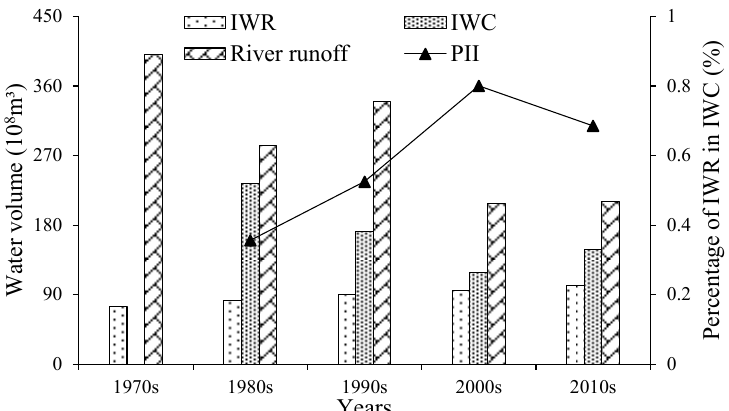
Figure 7. Comparison of the irrigation water consumption and inflow from the ARD during 1970–2019. Notes: IWR, irrigation water requirement; IWC, irrigation water consumption; PII, percentages of IWR in IWC.